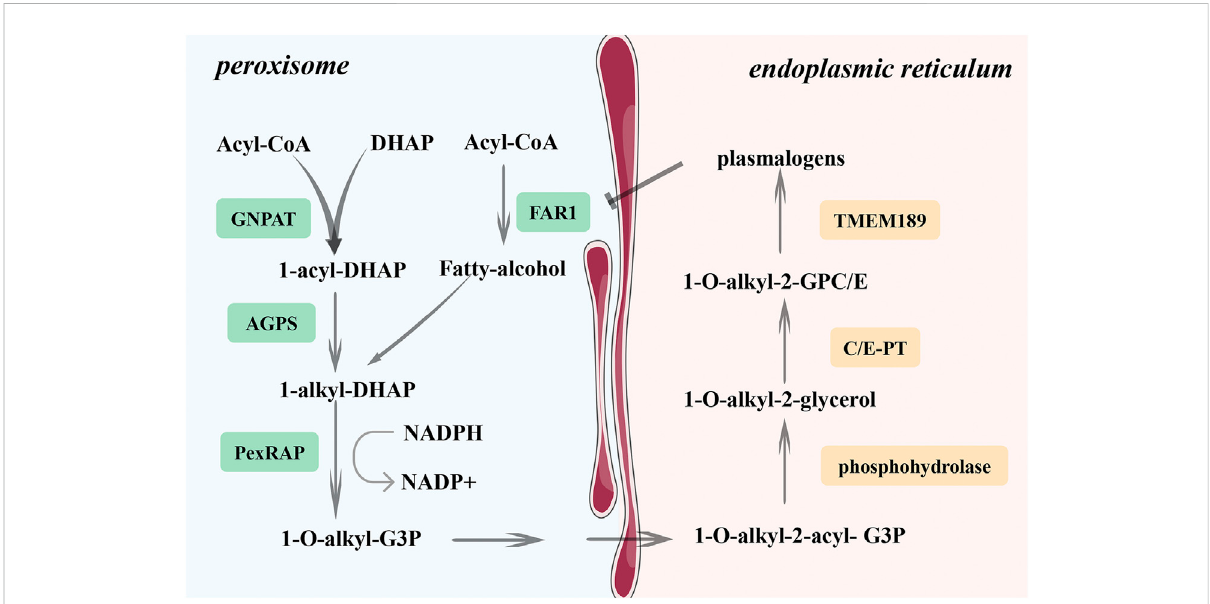
FIGURE 3 Synthesis of plasmalogens. FAR1 is a key enzyme in the synthesis of plasmalogen. It can convert saturated fatty alcohols into unsaturated fatty. The TMEM189 geneencodesplasmanylethanolaminedesaturase,whichcouldintroducethevinyletherdoublebondintoplasmalogensandconvert alkyl-etherlipidsintoplasmalogens.However,FAR1isregulatedbythenegativefeedbackofphospholipidlevel,anditcanbeinhibitedbyanincrease in plasmalogens content. FAR1, fatty acyl-CoA reductase 1; GNPAT, glyceronephosphate-O-acyltransferase; AGPS, alkylglycerone phosphate